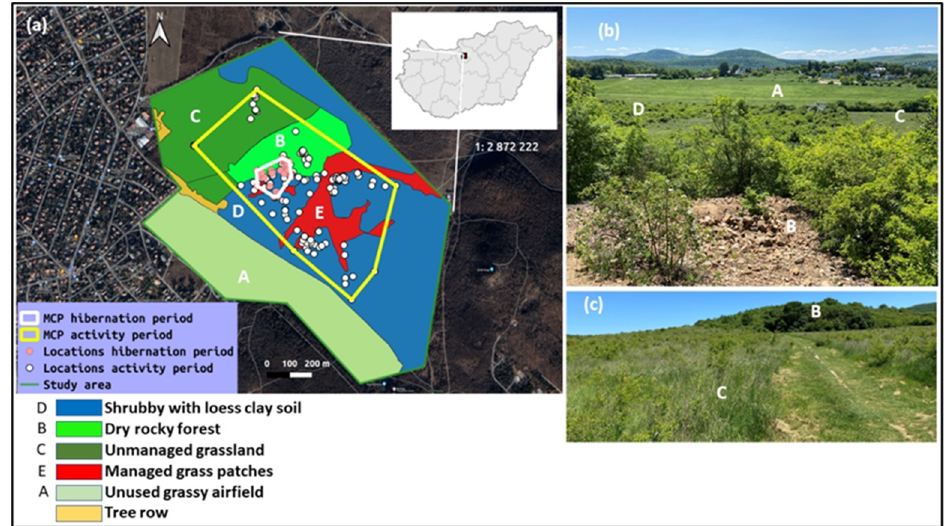
Figure 1. ( a ) Overall distribution of all telemetry points during activity period (n = 226) and hibernation period ( n = 83) of five Caspian whipsnakes ( Dolichophis caspius ), distributed in various habitat patches estimated using the minimum convex polygon (MCP) method. ( b ) and ( c ) images from the study area depicting different habitat patches. Capital letters on (a) correspond to those on (b & c) showing some of the habitat types.